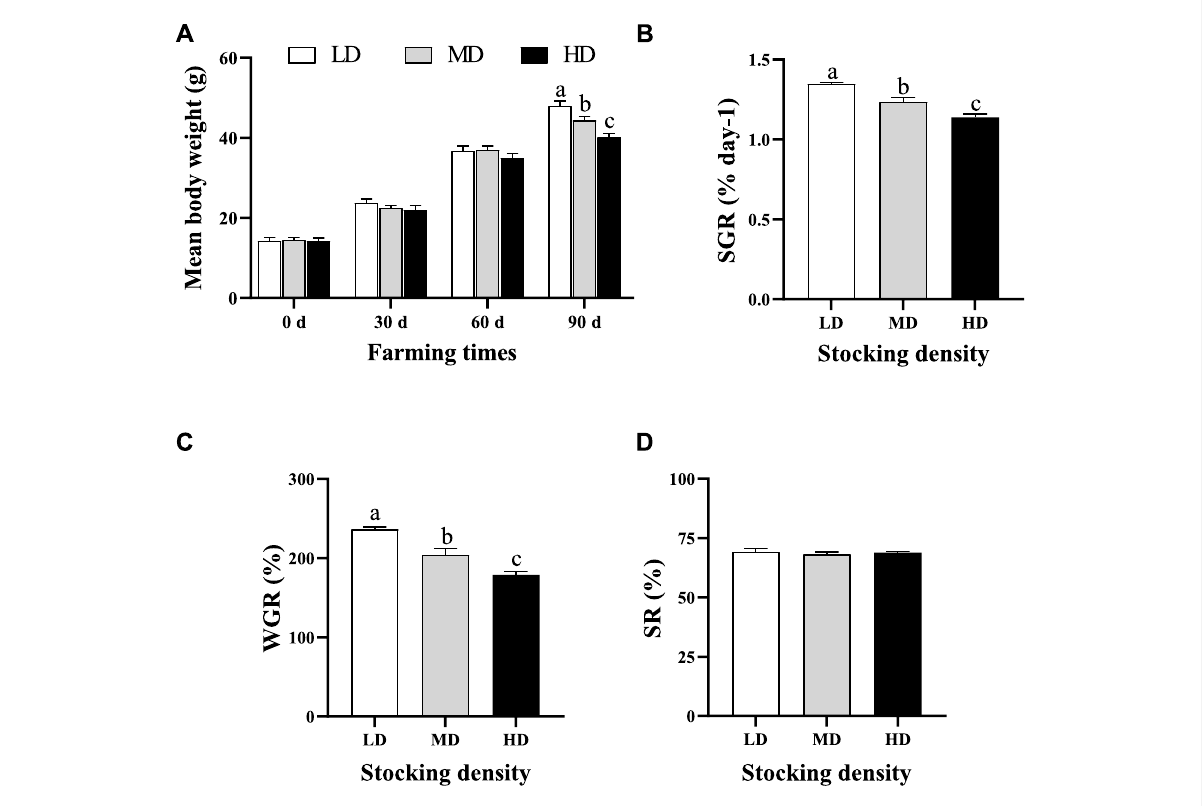
FIGURE 1 Mean body weight (A) , speci fi c growth rate (B) , weight gain ratio (C) and survival rate (D) of C. quadricarinatus under different densities in an integrated rice – cray fi sh farming system. Values are presented as means ± SE. Means with different superscripts denote signi fi cant differences ( p < 0.05). LD, low stocking density; MD, middle stocking density; HD, high stocking